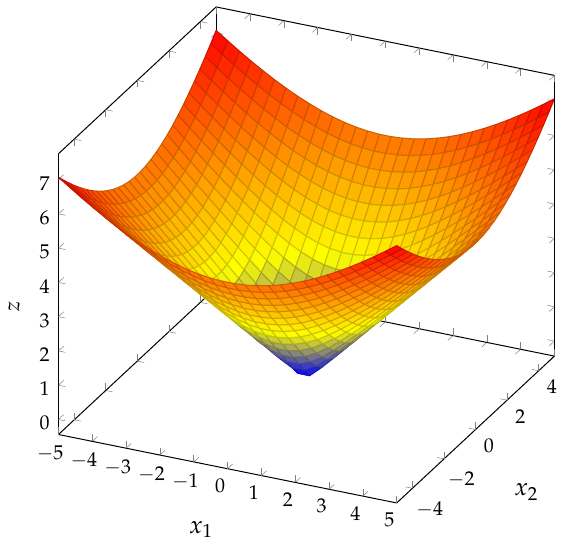
Figure 1. Representation of the second order cone Ω = {(cid:107) x (cid:107) ≤ z } . with x ∈ R 2 and z ∈ R